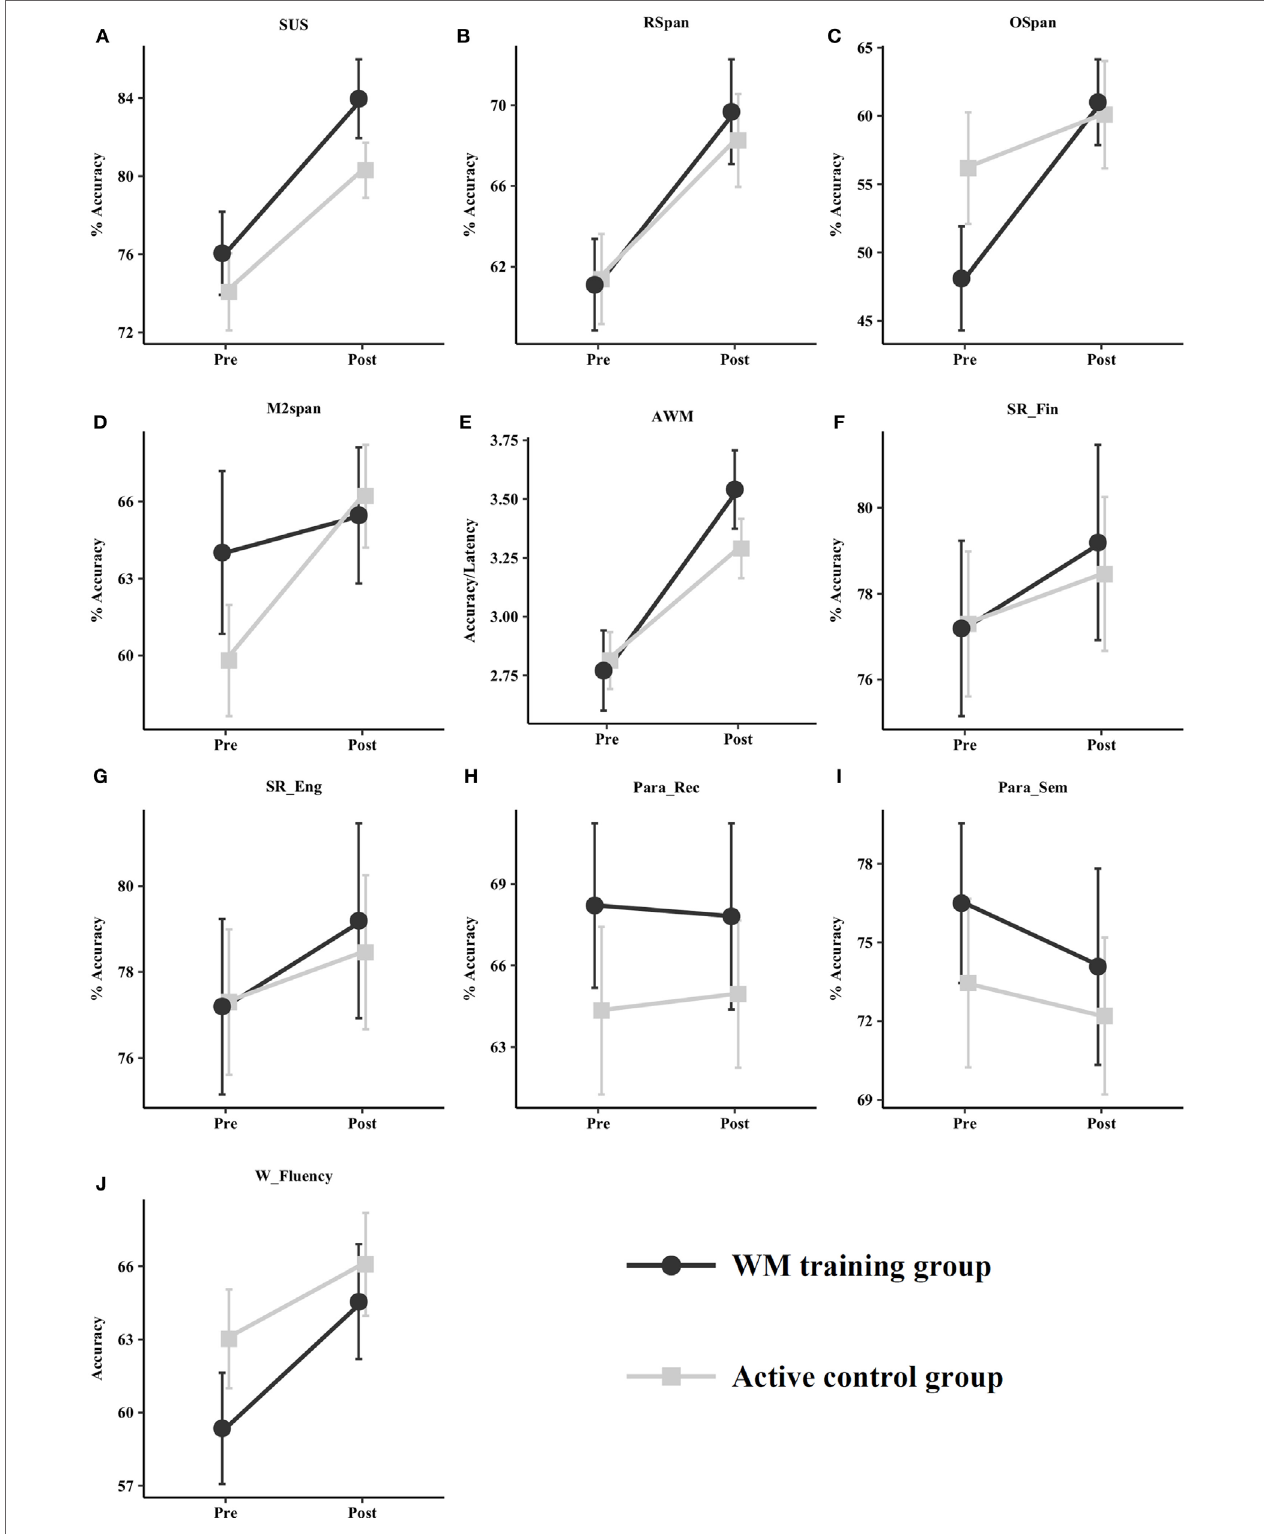
FigUre 4 | Pre–post means per group for the selective updating of sentences (SUS) task (a) ; Reading span (RSpan) task (b) ; Operation span (OSpan) task (c) ; Minus 2 span (M2span) task (D) ; Alphabet WM (AWM) task (e) ; Sentence recall (SR_Fin) in Finnish (F) ; Sentence recall (SR_Eng) in English (g) ; Paragraph recall (Para_Rec) (h) ; Paragraph semantic recall (Para_Sem) (i) ; and Word Fluency (W_Fluency) (J)